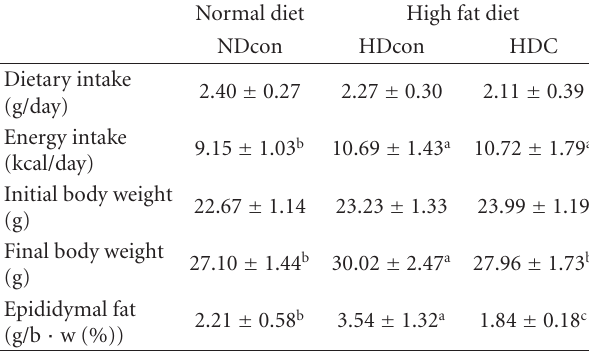
Values are means ± SD. Values with di ff erent superscript letters (a, b, c) indicate significant di ff erences among groups at P < . 05 by Duncan’s multiple range test.